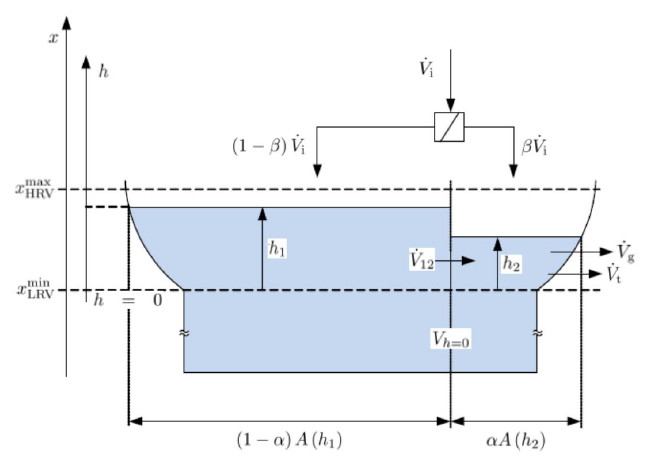
Figure 1. Schematic of lake Toke